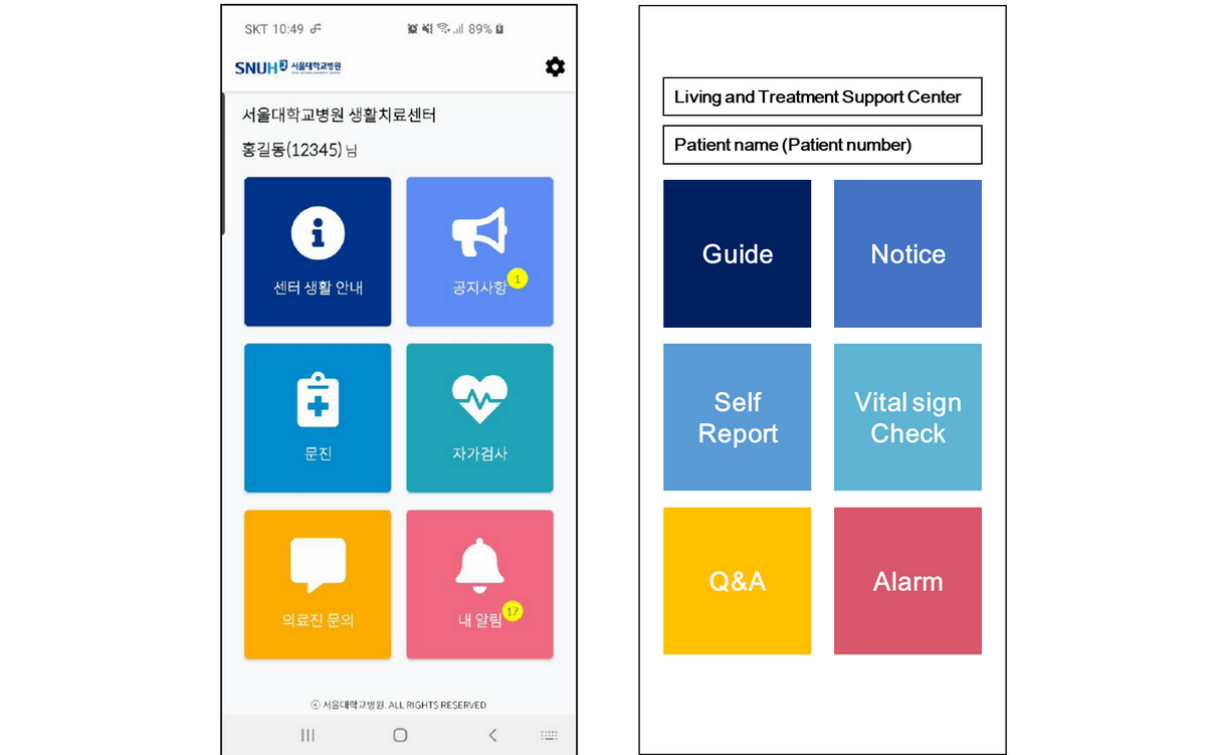
Figure 5. Interface of the mobile app for patients admitted to the LTCS. Q&A: question and